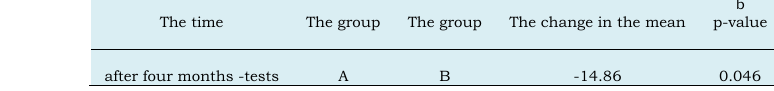
After four months, a paired comparison test revealed an important difference in total Cho concentration between groups A and B (average change =-14.86, p = 0.046). In Table 6 Total Cho (mg/dl) differences between the A and B groups after four